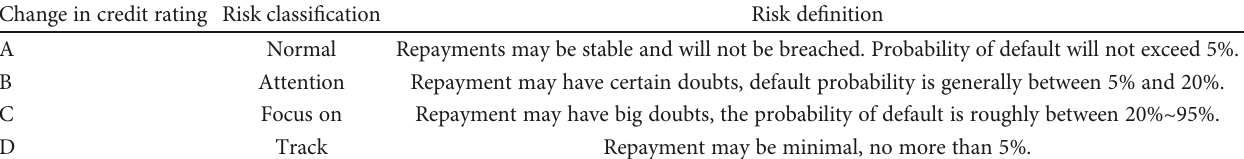
Table 4: Credit rating shift table.